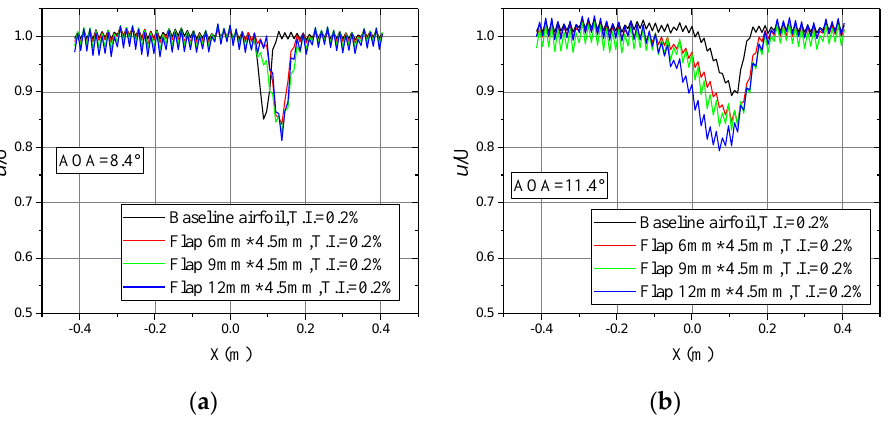
Figure 17. The wake velocity measured by the wake rake array (uniform inflow, Re: 0.8 × 10 6 ). ( a ) α = 8.4°; ( b ) α = 11.4°.